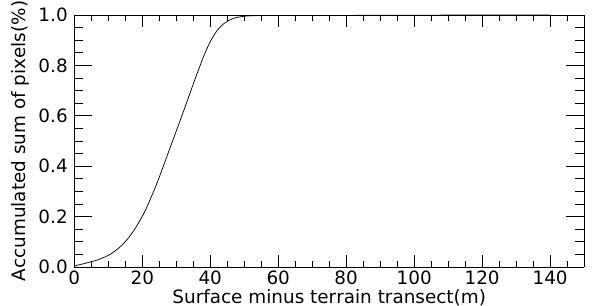
Figure 8. Accumulated sum of the differences from the unfiltered surface and terrain